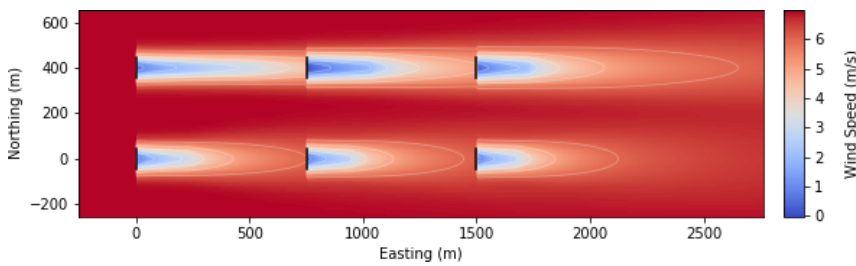
Figure 10. Visualization of a flow field with heterogeneous turbulence intensity. The turbines that experience higher turbulence intensity show a faster rate of wake recovery, and vice versa. Turbine rotors are indicated by black